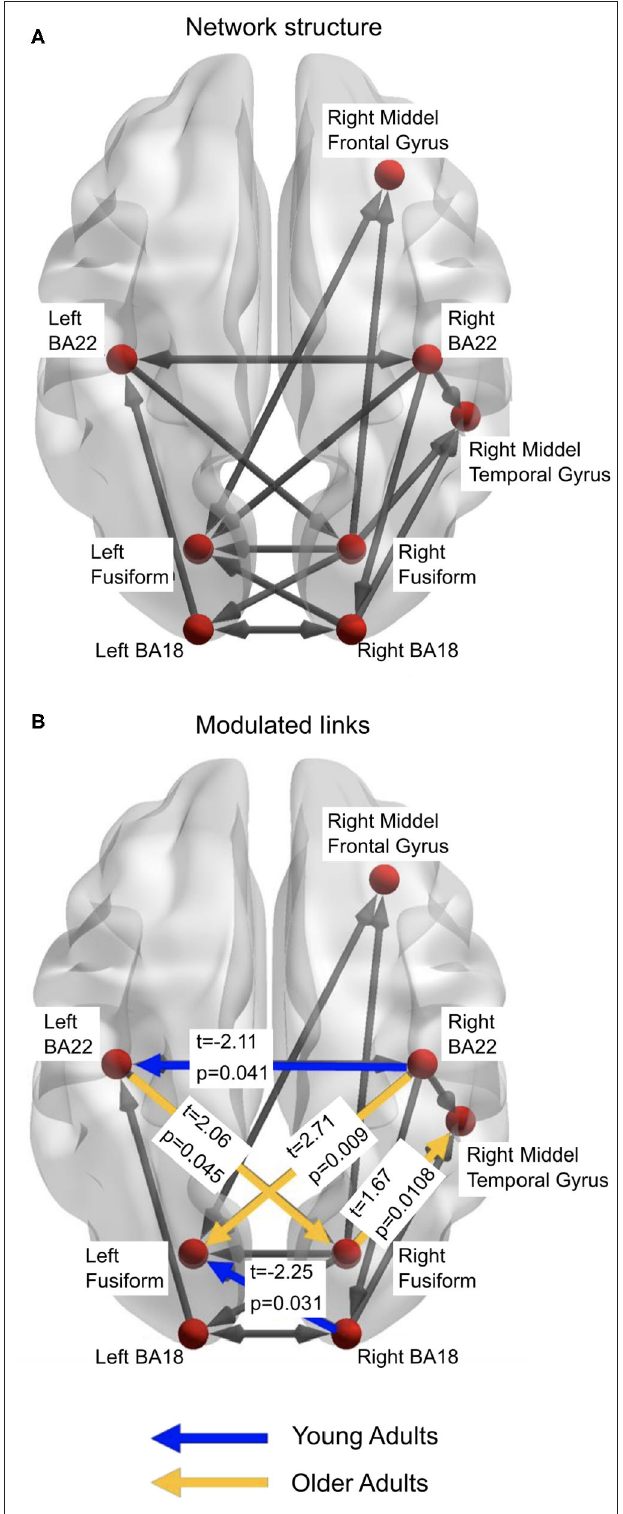
FIGURE 5 | (A) The winning model from the DCM analyses. This represents the structure of the network that is active in both young and older adults. (B) represents the links which demonstrate significantly more beta-band activity between the age groups. Figures generated with BrainNet Viewer (Xia et al., 2013